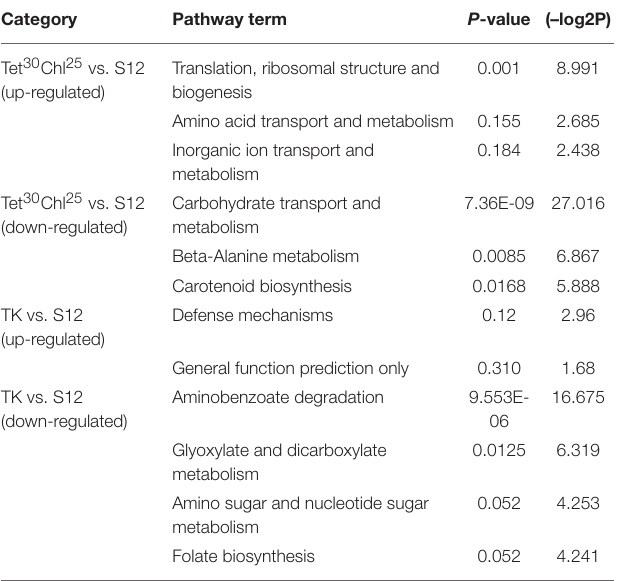
TABLE 1 | KEGG pathway analysis of genes differentially expressed genes (DEGs) between the mutant strain TK, Tet 30 Chl 25 , and the initial strain S12. Category Pathway term